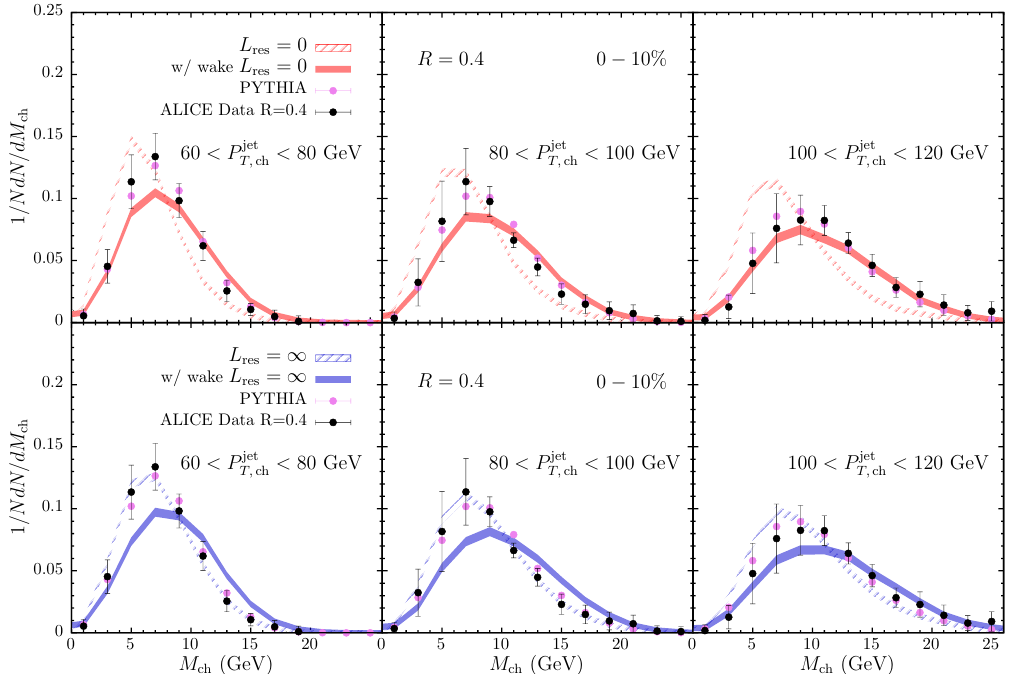
p s = 2 : 76 ATeV, for